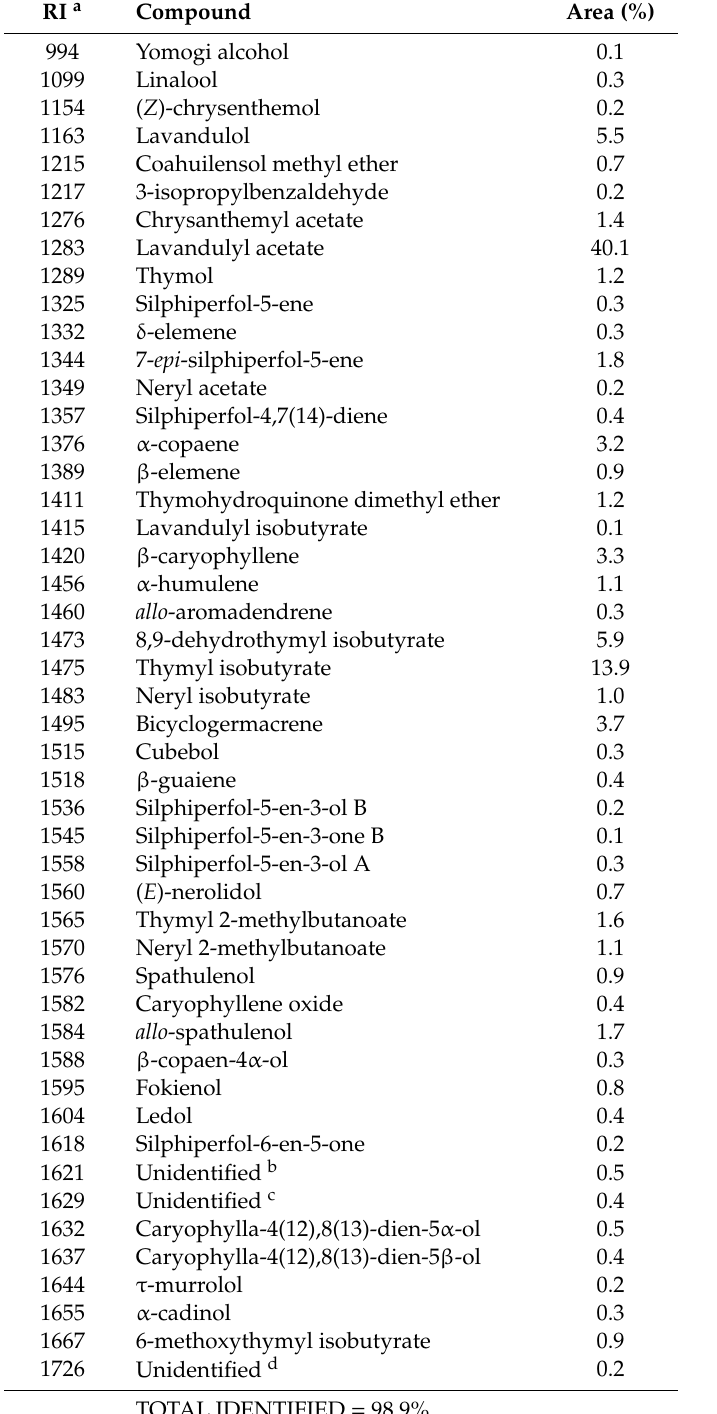
Table 1. Peak assignment for the gas chromatography–mass spectrometry profile of the essential oil extracted by hydrodistillation from Phania matricarioides collected in Bauta municipality, Artemisa,